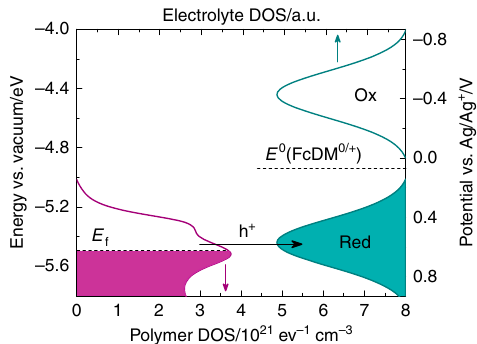
Fig. 2 Distribution of unoccupied and occupied states in polymer and electrolyte. The DOS of an e-P3HT fi lm derived from the experimental oxidation current in cyclic voltammetry (purple curve, bottom axis) is shown next to simulated distributions of occupied (Red) and unoccupied (Ox) states in the electrolyte according to Eq. (3) and an analogous expression for unoccupied states, assuming equal concentrations of red and ox (green curves, top axis). Simulation parameters were E 0 (FcDM 0/+ ) ≈ E 1/ 0/+ ) = +0.07 V vs. Ag/Ag + , λ = 0.5 eV 50 , and T = 298K. 2 (FcDM Occupancy of the P3HT DOS and hole transfer from polymer to the electrolyte are illustrated for the example of a Fermi level E f at − 5.5 eV